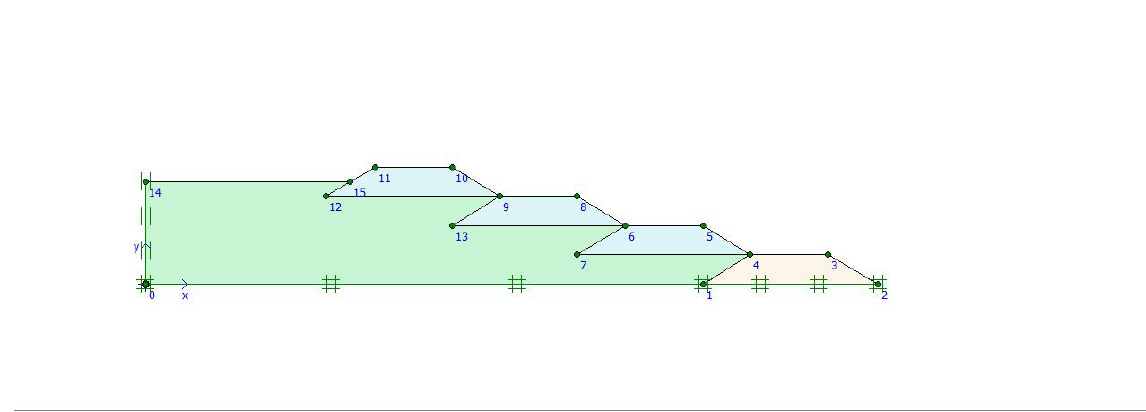
Figure 8. Cross section of upstream dam with its materials